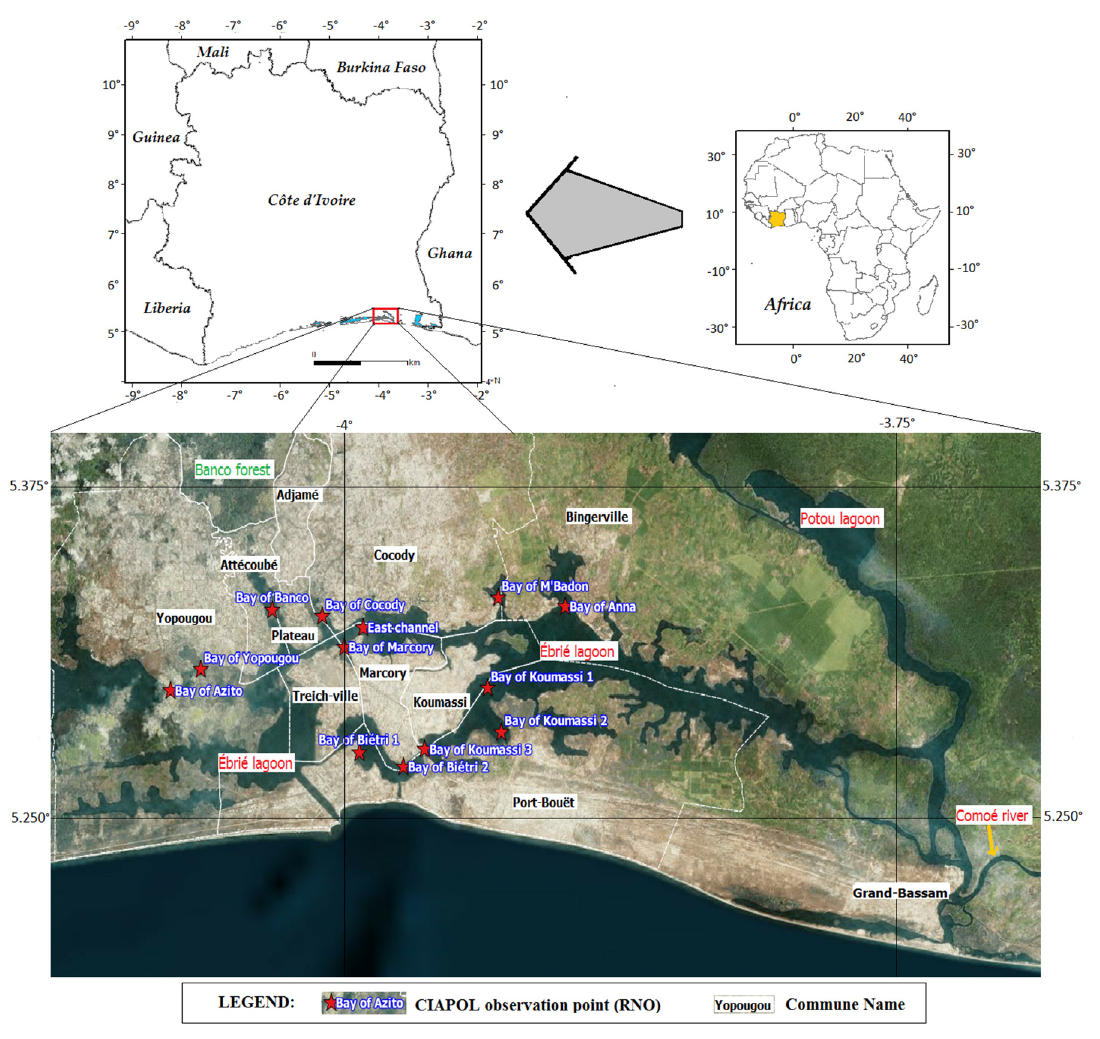
Figure 1. Presentation of Ébrié lagoon and the study area.